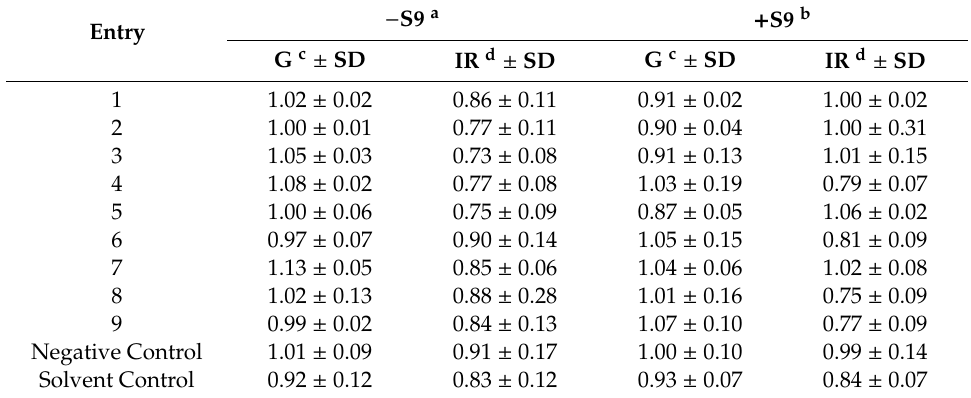
Table 4. The results of the umu-test for the highest concentrations of the tested extracts (0.66 mg /